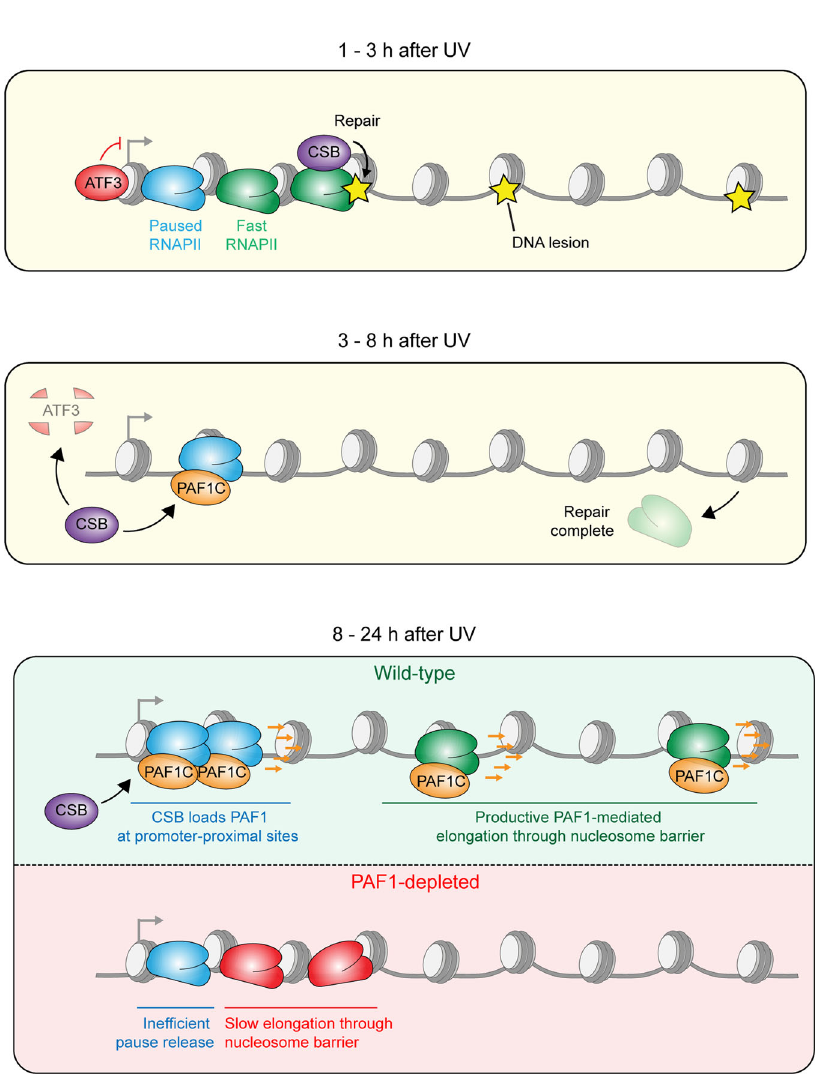
Fig. 9 Model of the role of PAF1C in restoring transcription across the genome after genotoxic stress. (Top panel) Within the fi rst 3 h after UV irradiation, RNAPII molecules stall at sites of DNA damages, inducing DNA repair through CSB. At the same time, the expression of transcriptional repressor ATF3 is strongly upregulated resulting in decreased transcription initiation at promoters. (Middle panel) CSB recruits the PAF1C to RNAPII paused around TSS sites and stimulates CSA-mediated degradation of ATF3. (Bottom panel) PAF1C binding to RNAPII around the TSS pause site subsequently promotes RNAPII pause release and stimulates productive elongation throughout